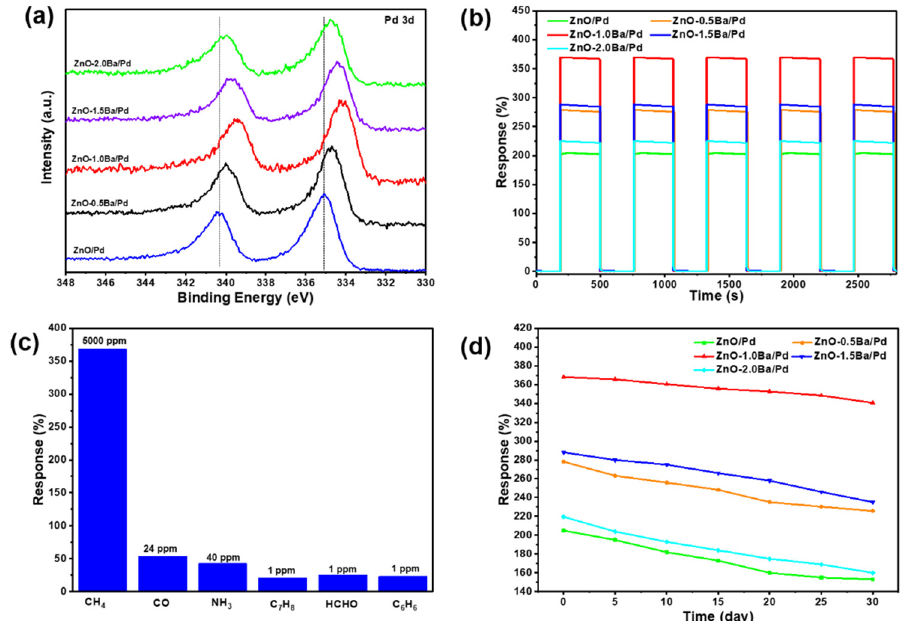
Figure 4. Gas sensing properties of ZnO/Pd, ZnO-0.5Ba/Pd, ZnO-1.0Ba/Pd, ZnO-1.5Ba/Pd, and ZnO- 2.0Ba/Pd for 5000 ppm CH 4 : ( a ) response at different working temperatures (120–300 °C), ( b ) dy- namic response (1000–5000 ppm), ( c ) relationship of the gas response to CH 4 gas concentration (1000–5000 ppm), ( d ) response and recovery curves of sensitive materials.